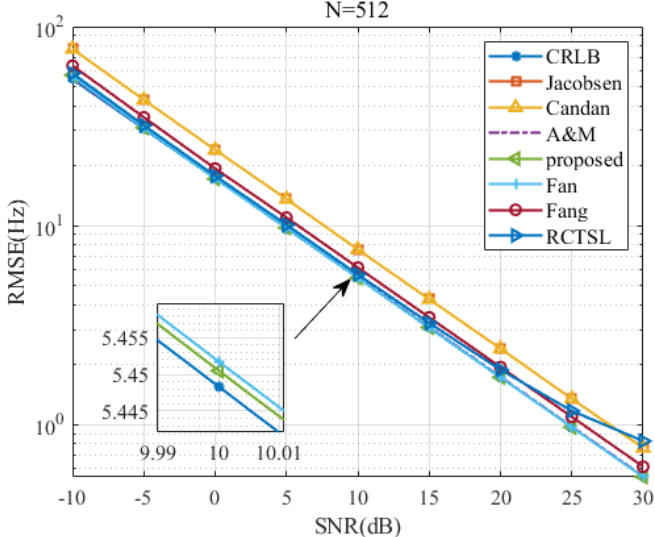
Figure 10. RMSE comparison among frequency estimates versus SNR at N = 512 and δ =